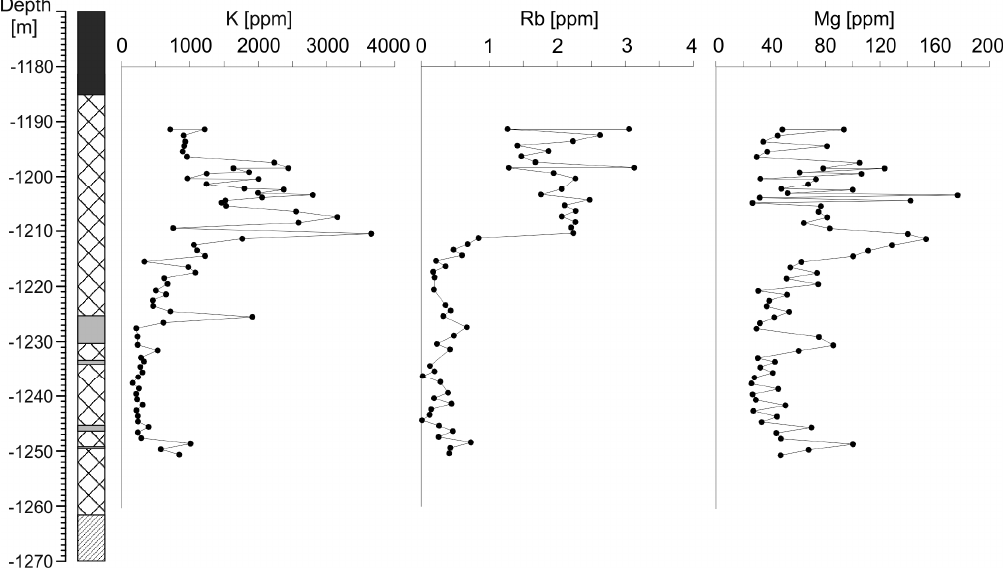
Figure 13. Distribution of potassium, rubidium, and magnesium in Lotsberg salt profile. Explanation as at Figure 12.